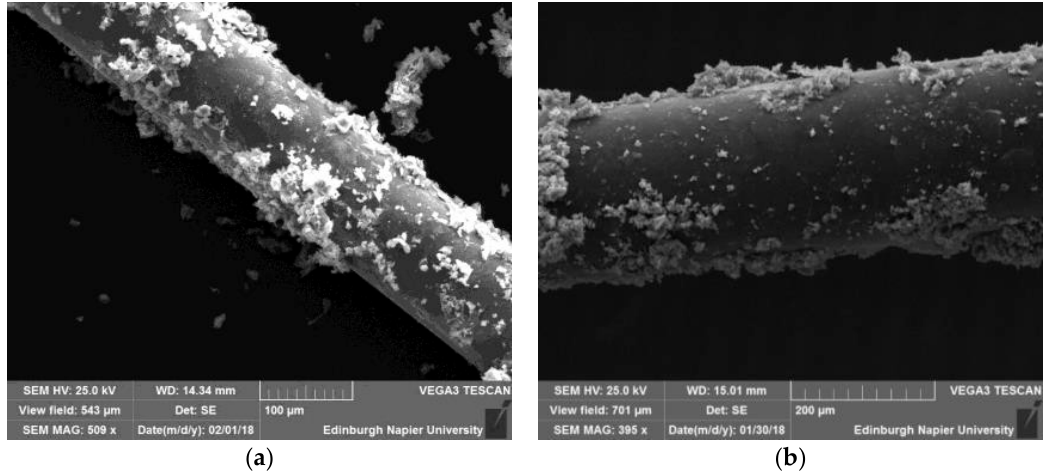
Figure 1. SEM image of the fibre with ( a ) GO evaporated; ( b ) GO co-electroplated.